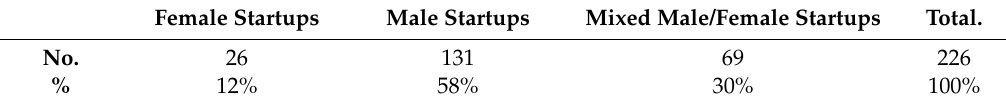
Table 2. Our sample of innovative startups by gender governance.